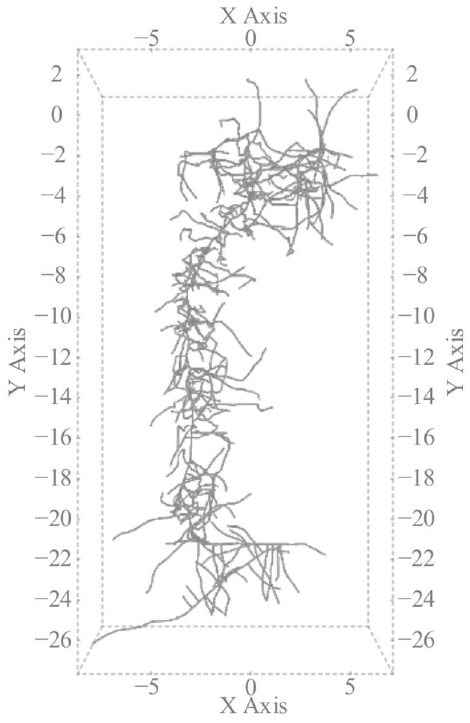
Figure 17. Three-dimensional visual simulation of root system .